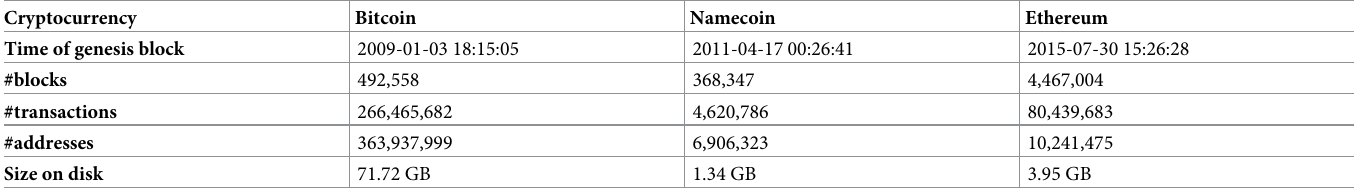
Table 1. Summary of cryptocurrencies studied in this